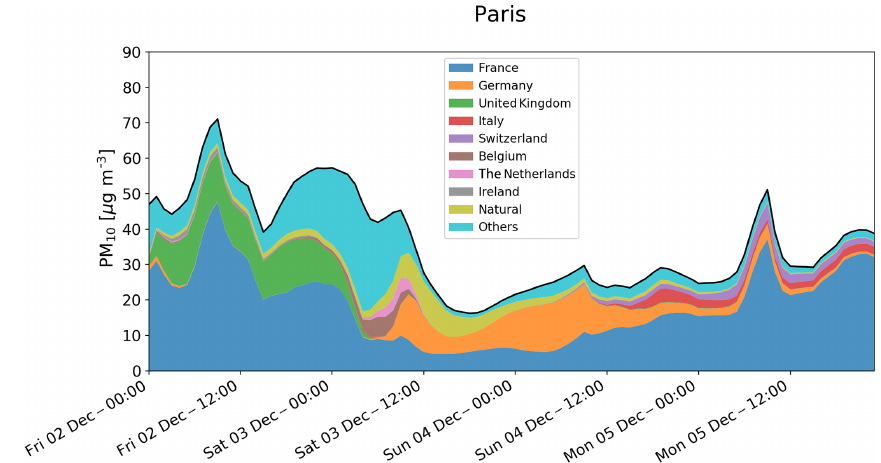
Figure 1. Hourly PM 10 concentrations, in micrograms per cubic metre, over Paris predicted by the EMEP model from 2 to 5 December 2016. The black curve highlights the total concentration. The eight main country contributors are plotted in addition to the natural sources and “Others”. Others contains hereafter other European countries, boundary conditions, ship traffic, biogenic sources, aircraft emissions, and